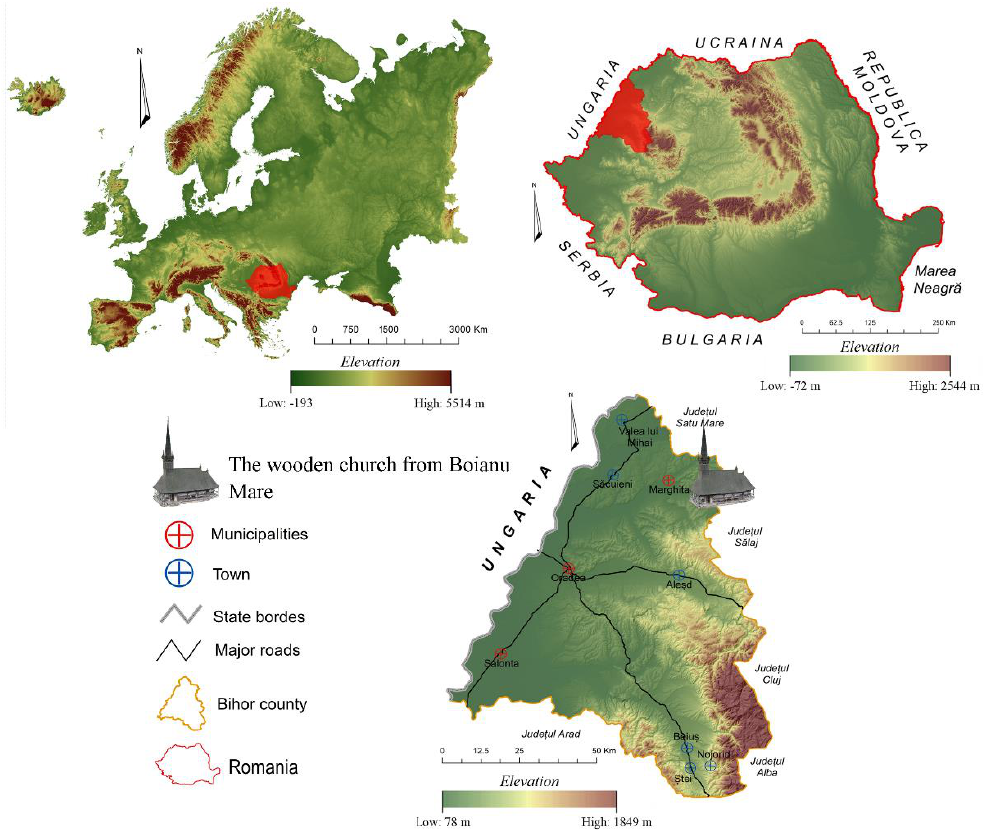
Figure 1. The location of the Wooden Church from Boianu Mare at the scales of Europe, Romania and Bihor County.